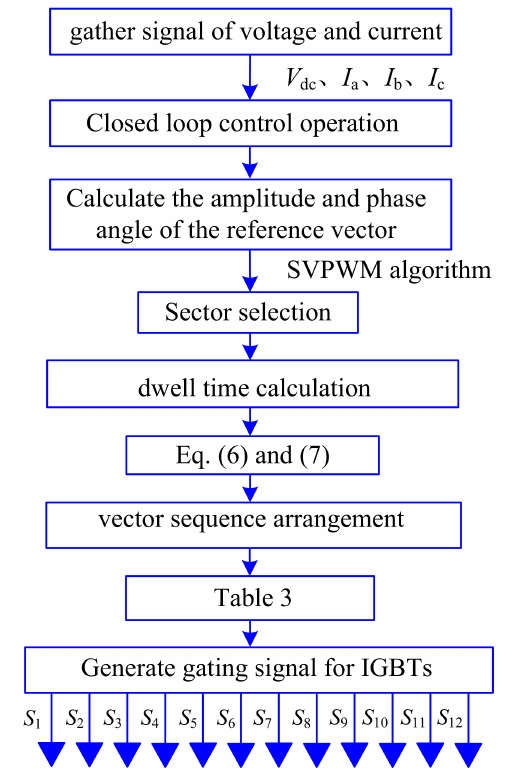
Figure 9. Control algorithm.